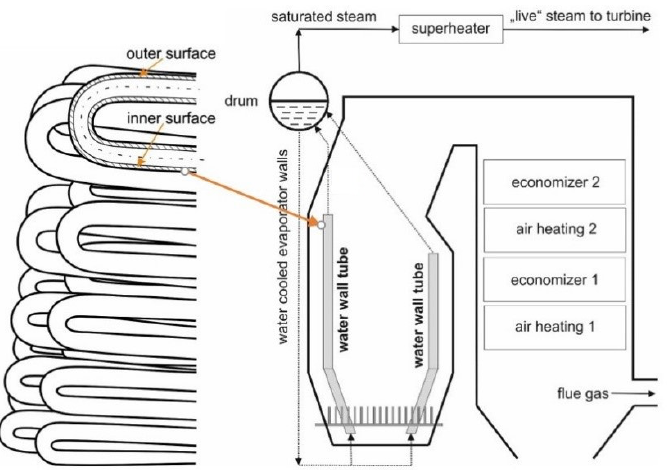
Figure 1. Scheme of the water wall tubes (the evaporator tubes) location in the combustion chamber of the boiler.